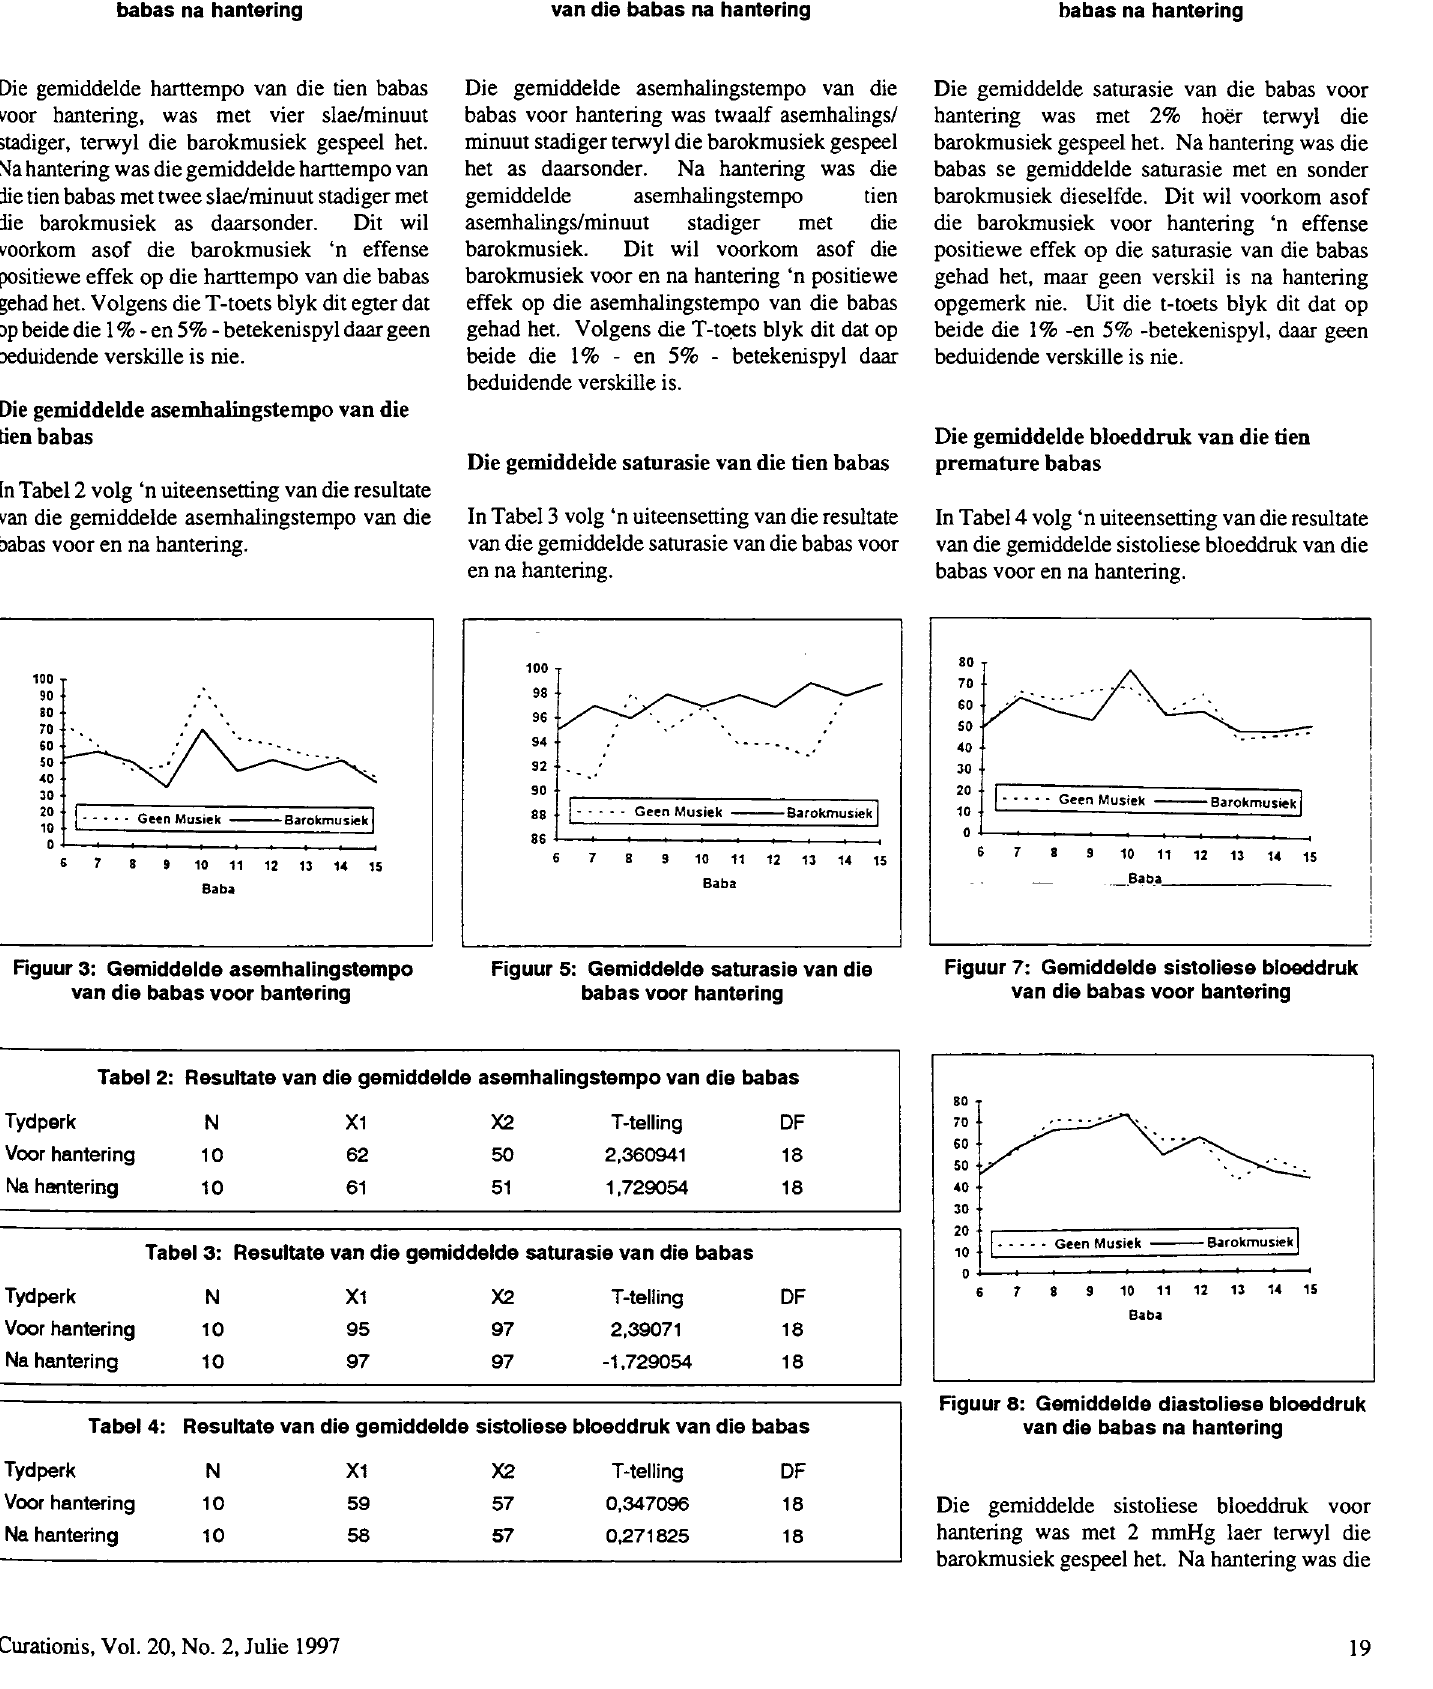
Figuur 2: Gemiddelde harttempo van die babas na bantering van die babas na bantering